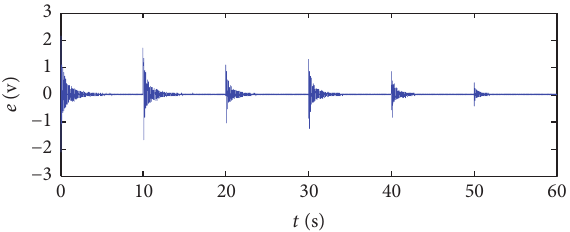
Figure 9: Control performance of the proposed method. secondary path with noise control system modeling method for duct-like applications. Real time experiments were done. The experimental results show that the proposed algorithm has good noise suppression performance while the secondary path changes. The transient process of multiple model